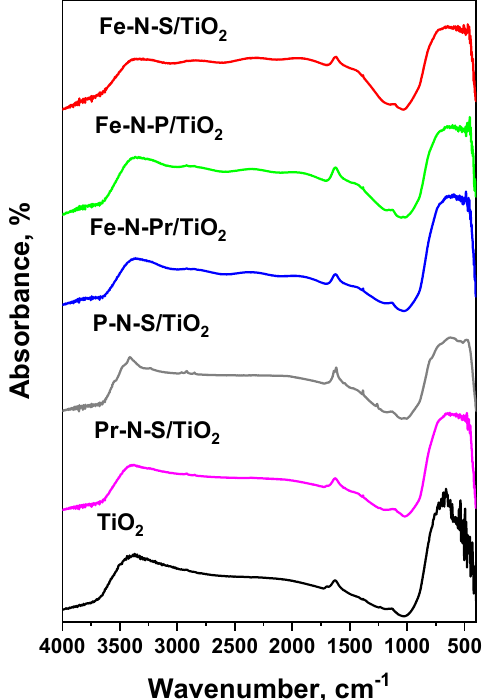
Figure 4. Fourier-transform infrared (FTIR) spectra of all prepared samples.